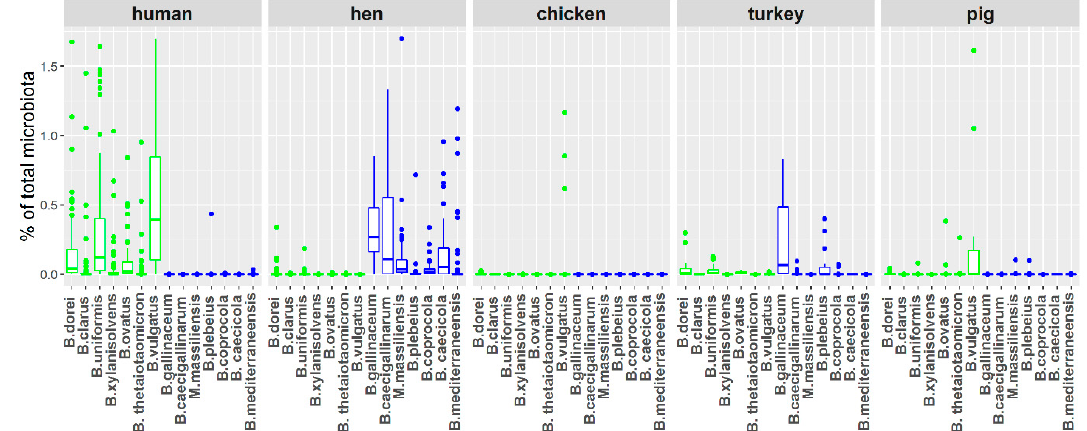
Figure 1. Host specificity of Bacteroides species. B. dorei , B. uniformis , B. thetaiotaomicron, B. vulgatus , B. xylanisolvens and B. ovatus (green boxes) were significantly more abundant in human samples than in hen or chicken samples (Kruskal–Wallis test followed by Dunn’s test, p < 0.01) and these therefore represent human-adapted species. B. salanitronis , B. caecigallinarum , M. massiliensis , B. plebeius , B. caecicola , B. mediterraneensis and B. coprocola (blue boxes) were significantly more abundant in hen than in human samples, and these therefore represent chicken-adapted